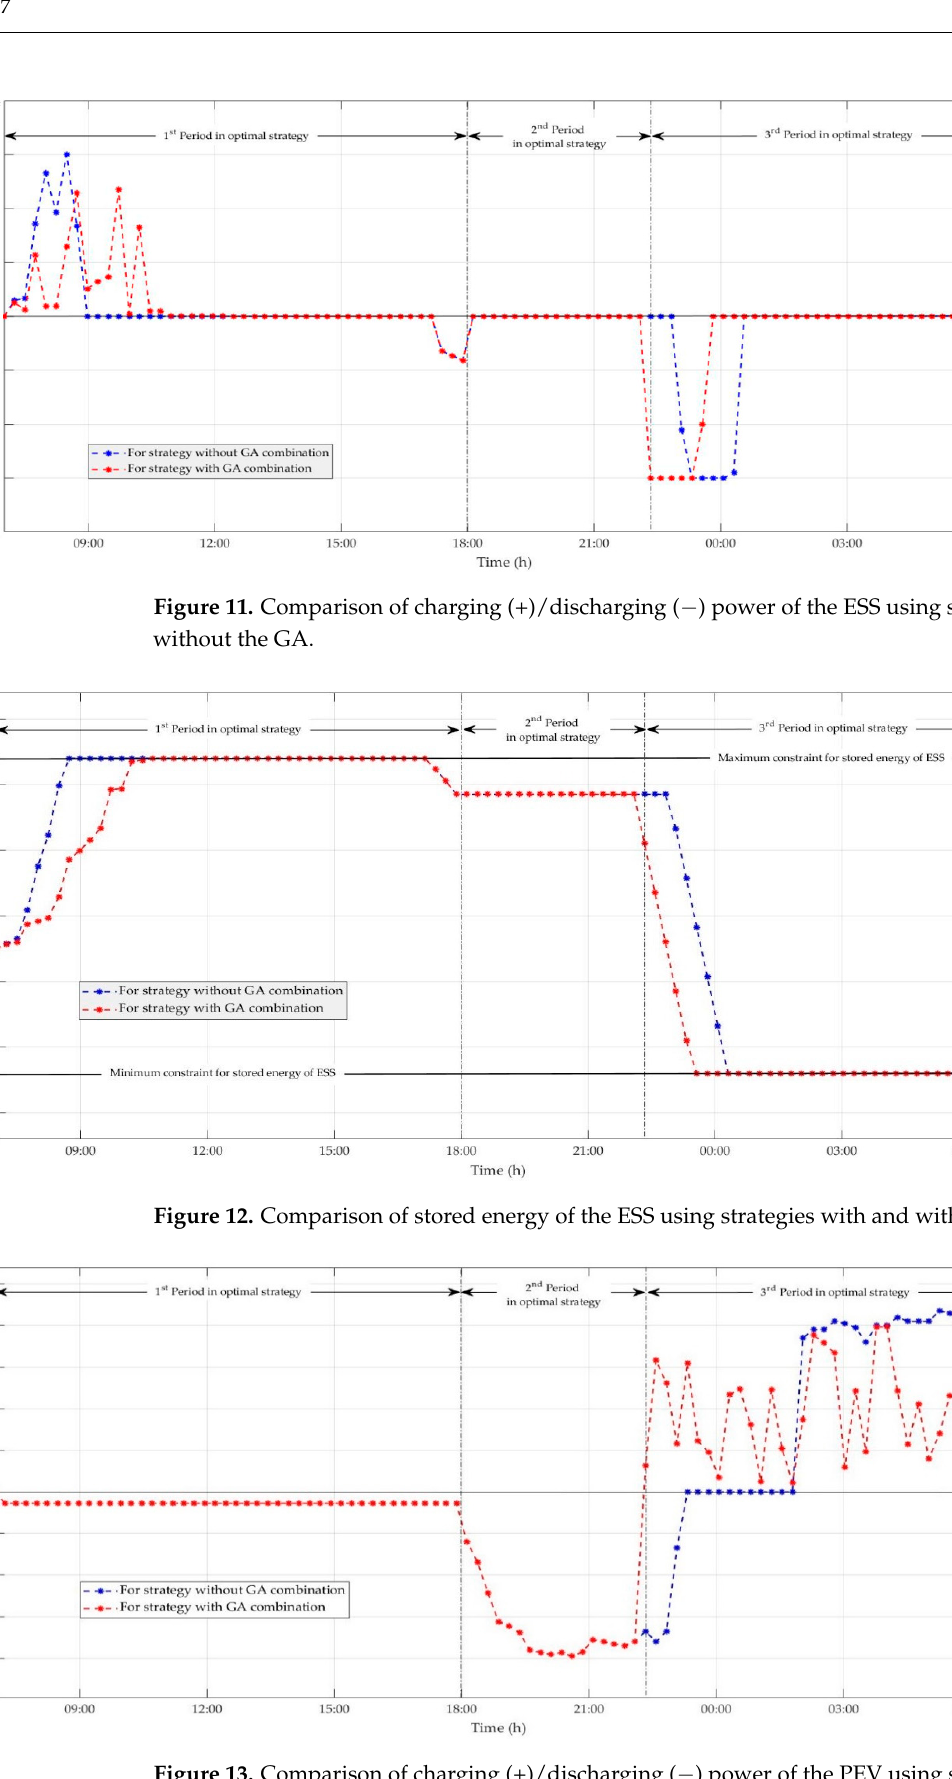
Figure 14. Comparison of stored energy of the PEV using strategies with and without the GA.